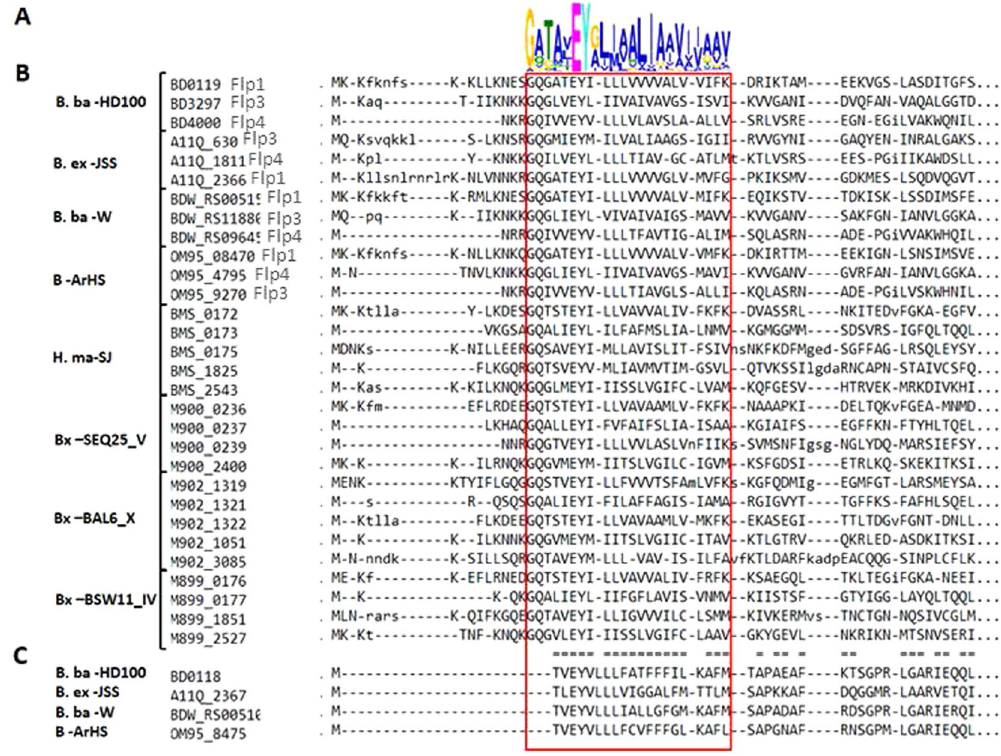
Figure 3. Multiple alignment of predicted flp sequences. Sequence logo representation representation 70 of a Flp pilin sequence position weight matrix (PWM), depicting the canonic Flp pilin motif (GXXXXEY and a stretch of hydrophobic amino acids). ( A ) Multiple alignment of Flp pilin sequences identified by the PWM in various BALO’s with the flp pilin motif indicated by a red outline. ( B ) Flp2 sequences are truncated forms of Flp pilins, both the N terminus proximal glycine (G) and the amino acid that follows it are missing, creating motif: MXXEY and a stretch of hydrophobic amino acids. The protein logo was created with MEME 60 . Multiple alignments were calculated using GLAM2 60, 71 . The Flp and the Flp2 multiple alignments were aligned to each other using the Compass program version 2.45 72 , with the similar regions indicated by the ‘ = ’ marks in between the multiple alignments. Lower case letters are regions not found to be significantly aligned by GLAM2. BALO designations are as in Fig.